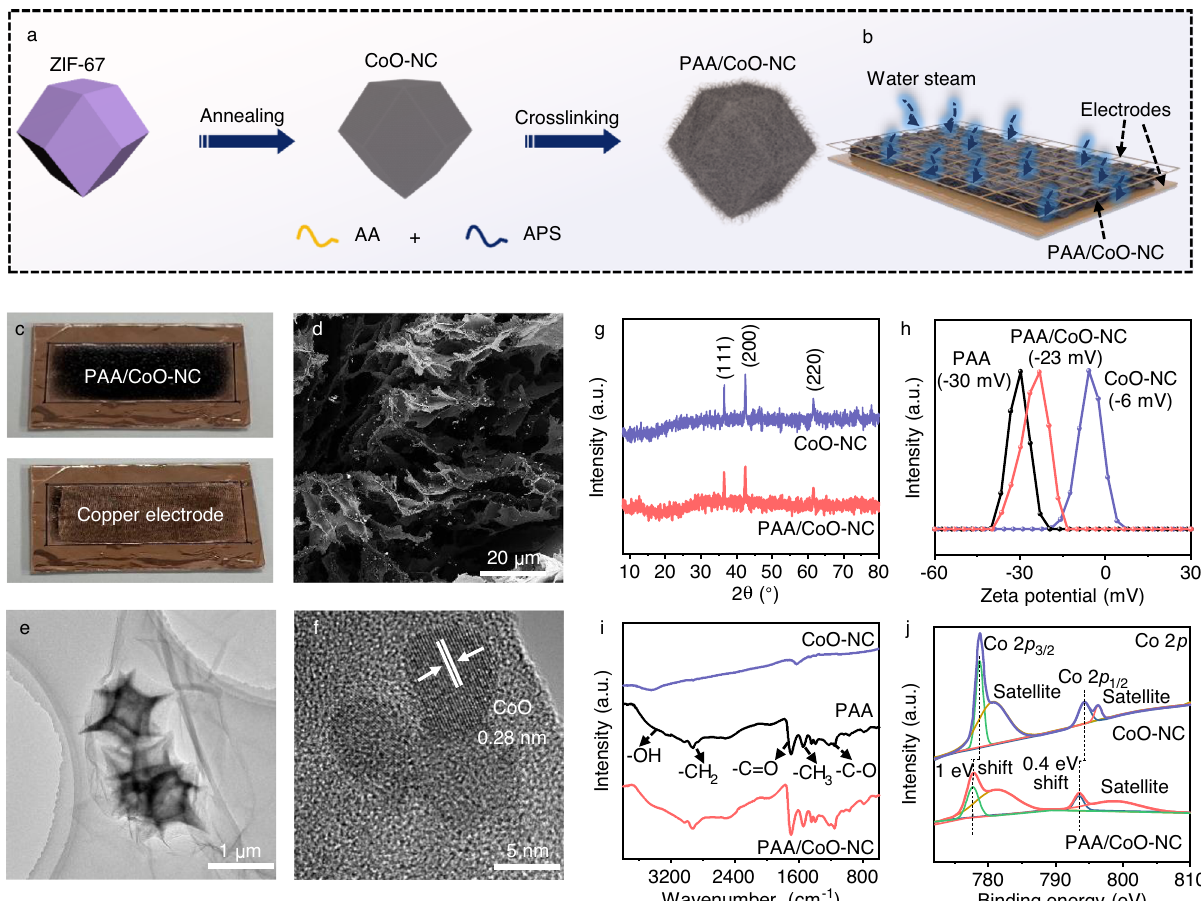
Fig. 1 | Synthesis and characterization of the hydrovoltaic effect-enhanced photocatalysis system. a The preparedprocess of PAA/CoO – NC(AA: